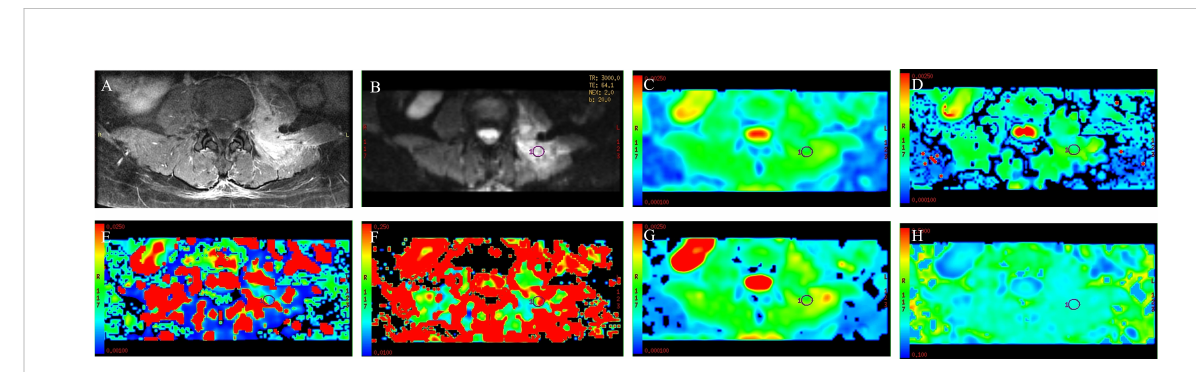
FIGURE 1 A 53-year-old man with spinal metastasis from lung cancer. The lesion showed obvious enhancement on T1WI (A) and hyperintensity on DWI (B) . ADC values were 0.926 × 10 − 3 mm 2 /s (C) . The ROI was placed on DWI (B) and copied to the other IVIM parametric maps of ADC slow , ADC fast , f, DDC, and a (D – H) with values of 0.8 × 10 − 3 mm 2 /s, 0.0211 mm 2 /s, 0.139, 0.945 × 10 − 3 mm 2 /s, and 0.759,